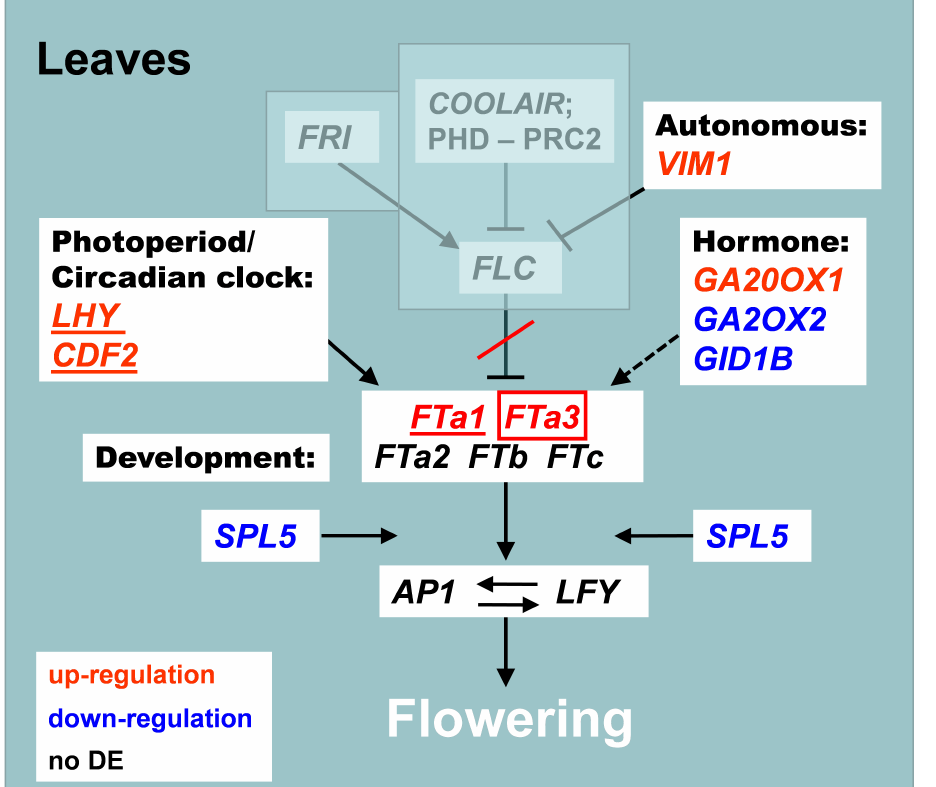
Figure 6. Putative regulatory interactions underlying flowering promotion in response to vernal- ization in chickpea. The scheme places the DEGs from Figure 3 into the context of Figure 1. The names of the DEGs found in the mutant ICCV 96029 are underlined. The FTa3 gene, which is the common DEG in mutant and other C. arietinum accessions, is shown in the box. Upregulated and downregulated genes are shown in red and blue, respectively. The dashed arrow corresponds to the indirect/putative mechanism (FLOR-ID database, [6]). The mechanism of vernalization response via FLC , which is presumably missing in Cicer , is shown in pale